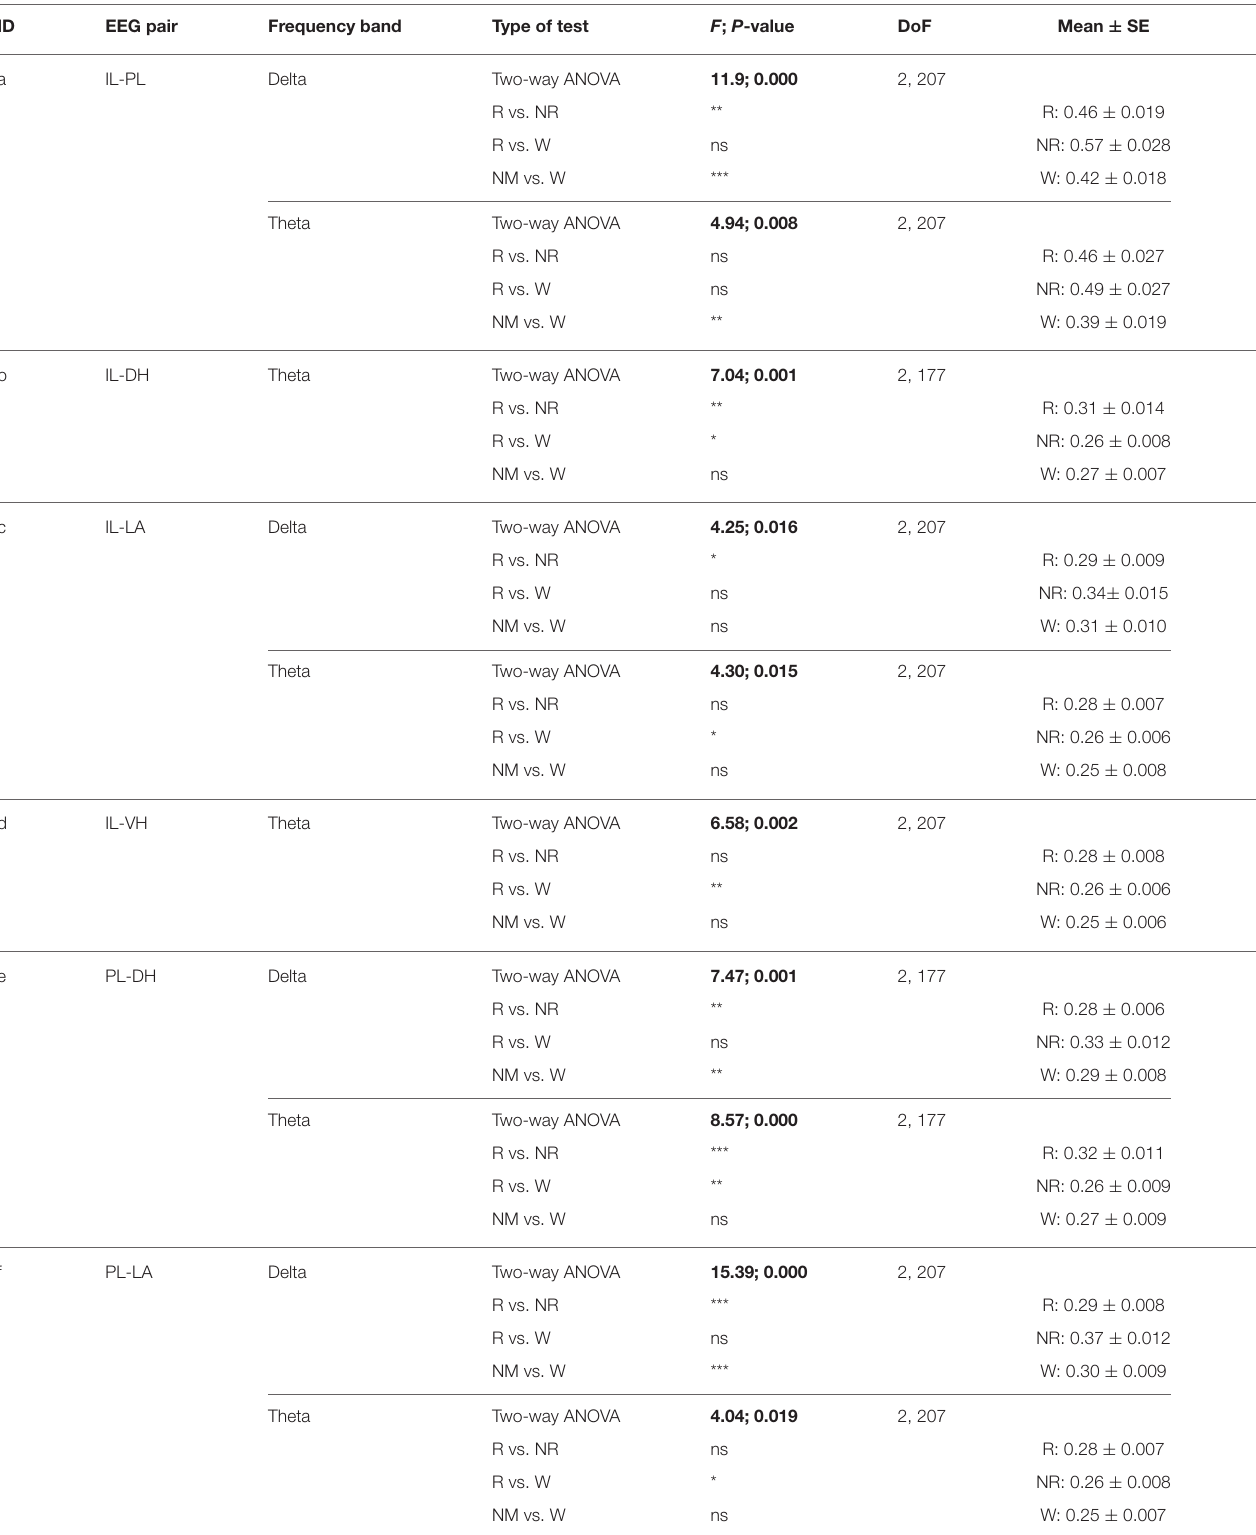
TABLE 1 | Significant differences in delta and theta synchrony across vigilance